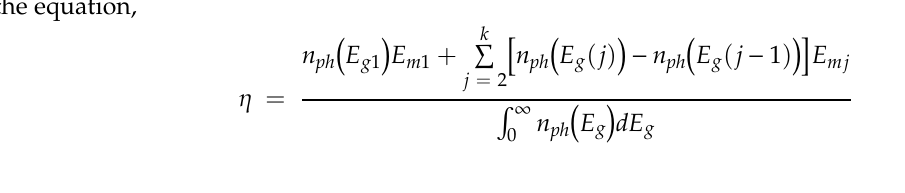
Figure 12. Edge-injection experiment in which photons run parallel to pn -junction of Si solar cell. We have observed photovoltaics in this configuration. In this experiment, a prism and thin film waveguide are used.